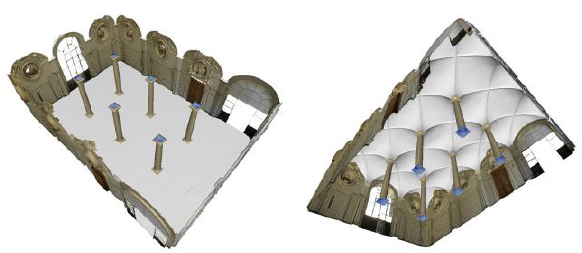
Figure 9. Point cloud segmentation before scan to BIM modelling in Revit